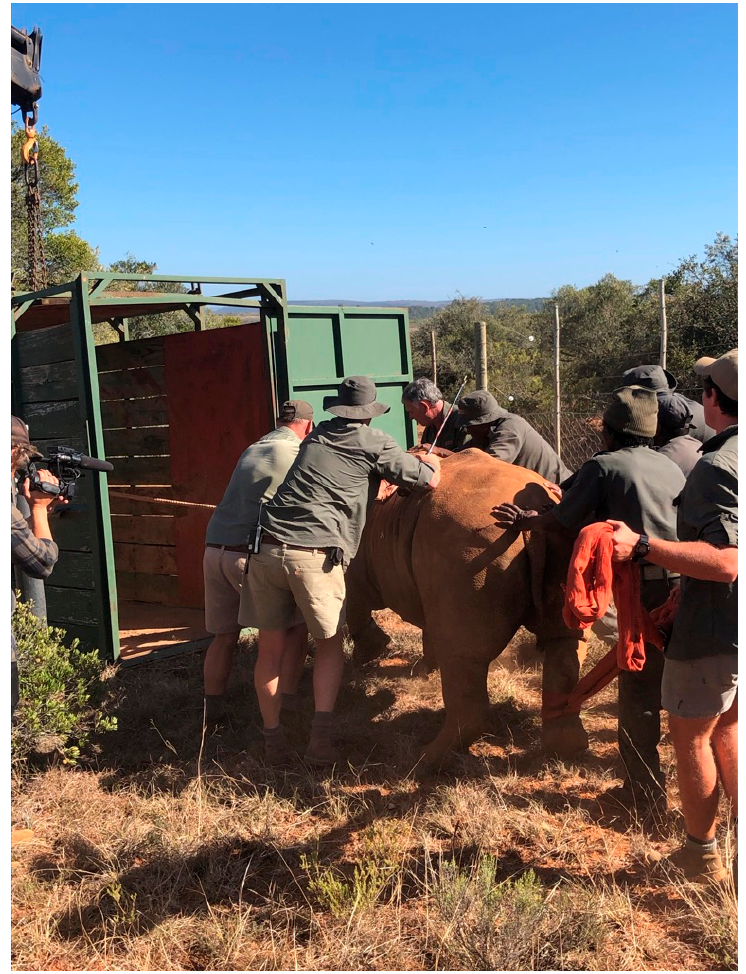
Figure 2. Walking the rhino into the crates. Animal is led to crates pulled by a rope tied around its head and pushed from the back at the same